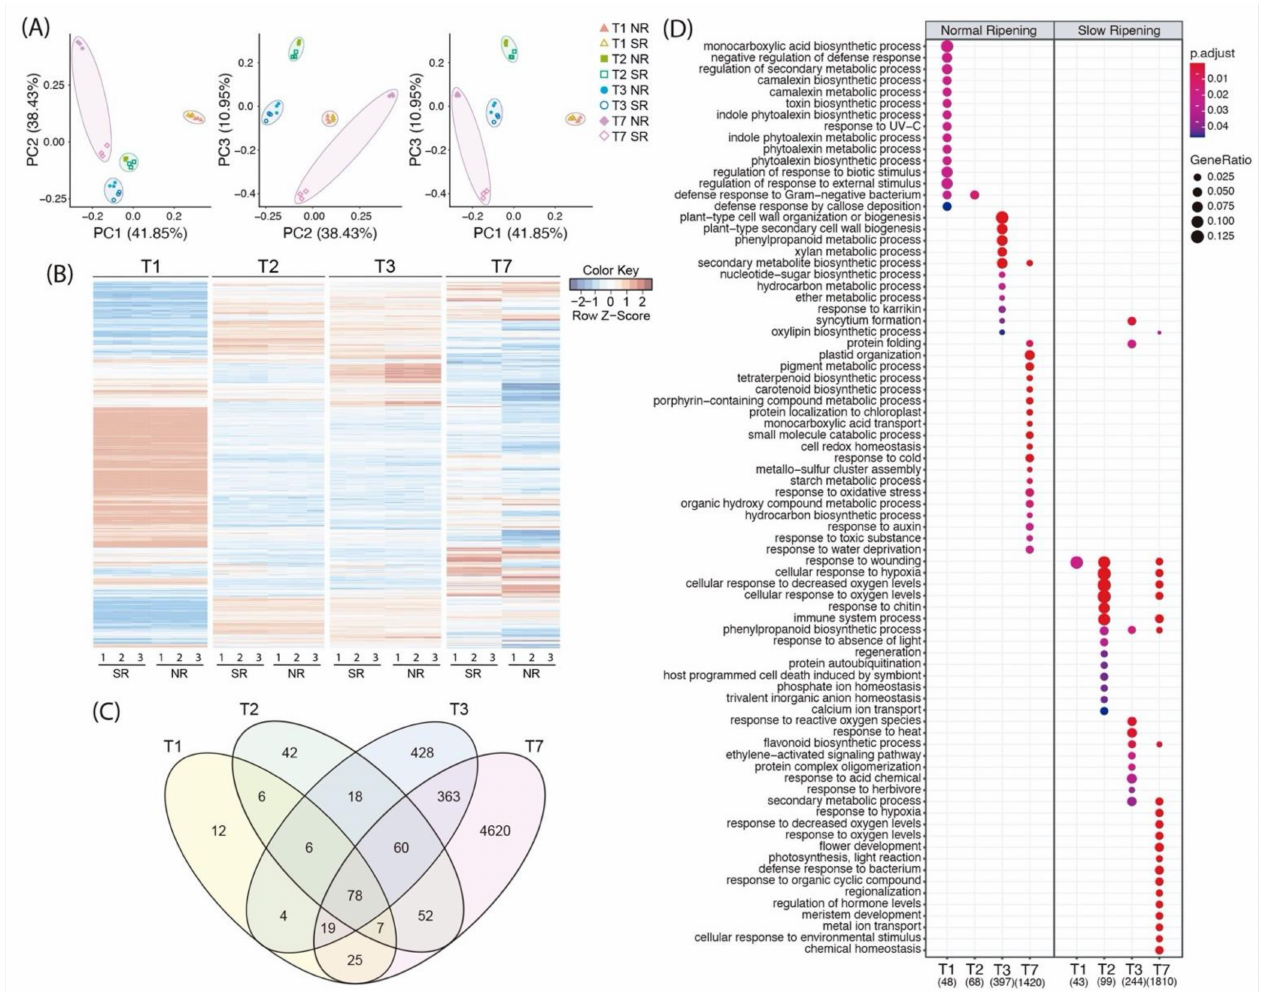
Figure 2. Differential expression analysis between NR and SR phenotypes. Graphical representation of differentially expressed transcripts for the four developmental stages analyzed (T1, T2, T3, T7) between the NR and SR phenotypes. ( A ) Principal component analysis using differentially expressed transcripts. The different stages are separated in colored circles of red, green, blue and purple for T1, T2, T3 and T7, respectively. The NR phenotype is represented with fullly colored figures and the SR phenotype is represented with line colored figures. ( B ) Heatmap of differentially expressed genes between NR and SR phenotypes. The red and blue lines represent genes with up and down regulated expressions, respectively. The four developmental stages are separated, and each column represents one independent biological replicate expression result. ( C ) Venn diagram representing the differentially expressed transcripts. In yellow, green, blue and purple, the differentially expressed transcripts only occurring in T1, T2, T3 and T7, respectively are represented, and the number of identified genes differentially expressed in all developmental stages are presented in grey. ( D ) Gene ontology term enrichment analysis of normal and slow ripening phenotypes in fruit development. The blue-red scale color represents the adjusted p-value and the point size represents the DE gene